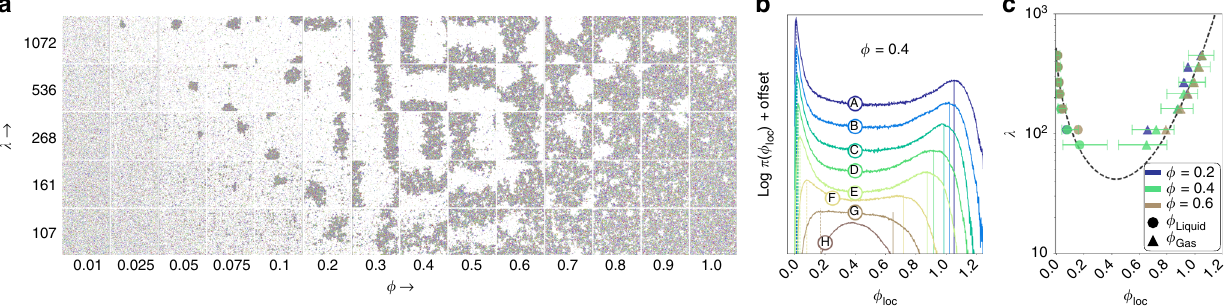
Fig. 3 Characterisation of motility-induced phase separation. Data for N ≈ 1.1 × 10 4 , δ = 0.7. a Snapshots of con fi gurations close to the onset of liquid – gas coexistence. (Particles represented in arbitrary size and colour-coded, as in Fig. 2e, according to their local orientation parameter.) U-shaped phase boundary is apparent. Orientational order is short-ranged in both liquid and gas phase, thus the coloured snapshots appear grey. At constant activity λ , the liquid volume fraction grows with increasing density until the liquid entirely fi lls the system. The location of the critical point depends on δ and it appears at a smaller density and λ than in Fig. 2. b Histograms of local densities (see Methods for de fi nition) for a variation of activities at constant ϕ = 0.4 (A: λ = 450; B: λ = 359; C: λ = 268; D: λ = 214; E: λ = 161; F: λ = 107; G: λ = 80; H: λ = 54; For better presentation, histograms are shifted along the y axis with increasing λ ). Transition from a single-peaked to a double-peaked distribution and increasing separation of peaks with increasing λ . c Densities of liquid and gas (identi fi ed through peak position as in b ) in an activity λ vs. local density ϕ loc diagram. This demonstrates independence of phase densities on global density for fi xed λ and validates the phase-separation picture. For a clear presentation, we plot exemplifying error bars for ϕ = 0.4 only, which were obtained from the width of the corresponding peak in b